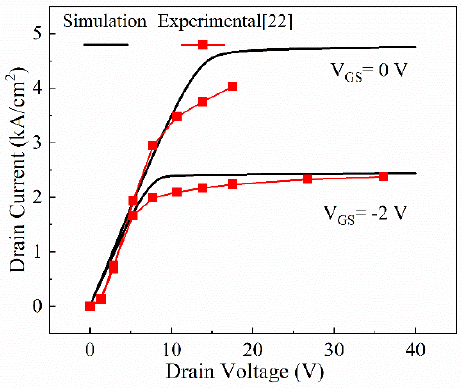
Figure 2. Experimental- [22] and numerical-result comparison of on-state I–V characteristics.